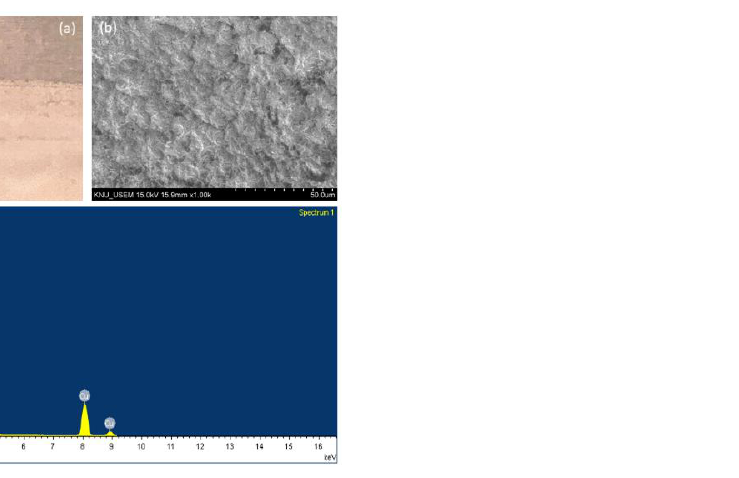
Figure 9. XRD patterns of deposited Cu product on the cathode at optimal conditions.